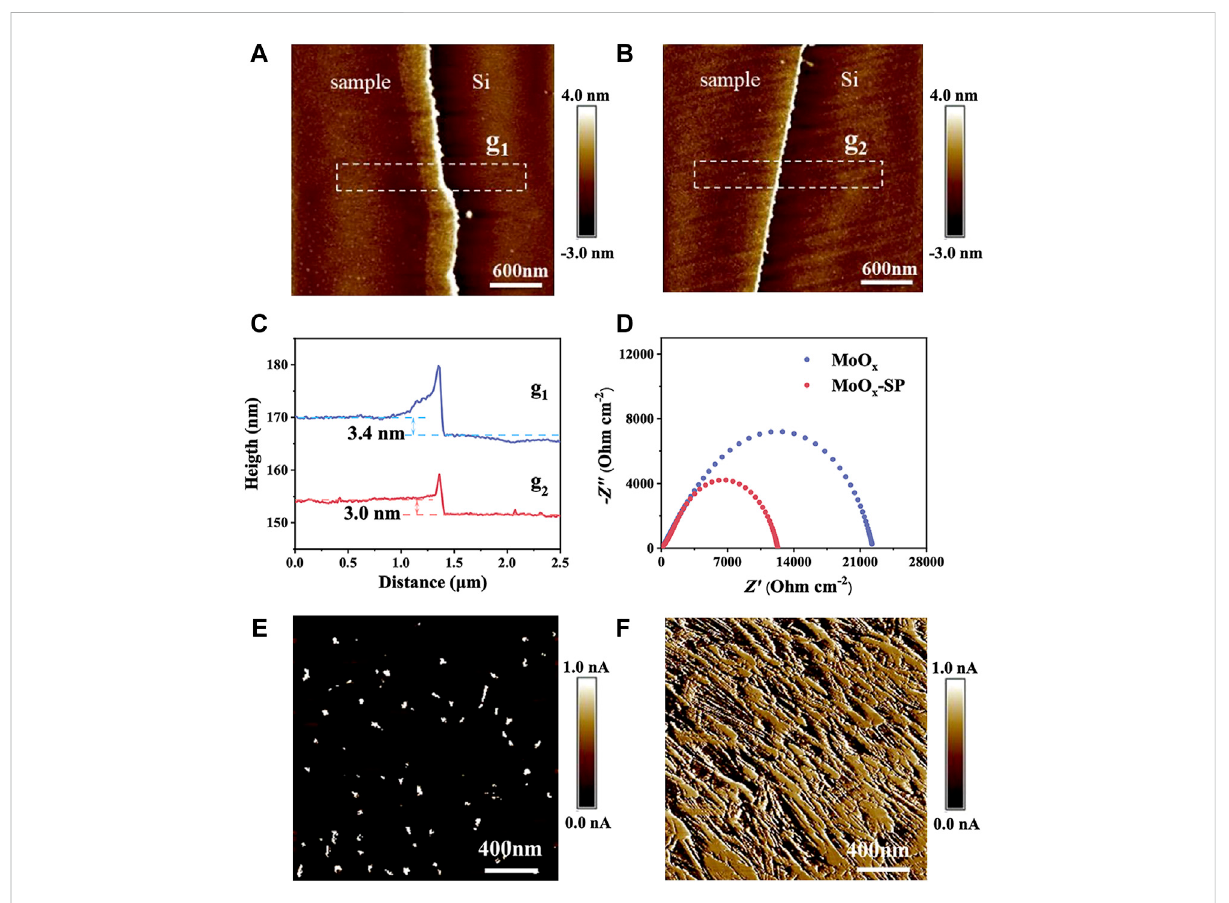
FIGURE 3 AFMsurfacemorphologiesof (A) theMoO x and (B) MoO x -SPthin fi lm.Thecorrespondingheightpro fi les (C) oftheMoO x andMoO x -SPthin fi lm in two regions shown in (A) (g1) and (B) (g2). Nyquist plots (D) of the MoO x and MoO x -SP thin fi lm. C-AFM images of (E) the MoO x and (F) MoO x -SP thin fi lm.